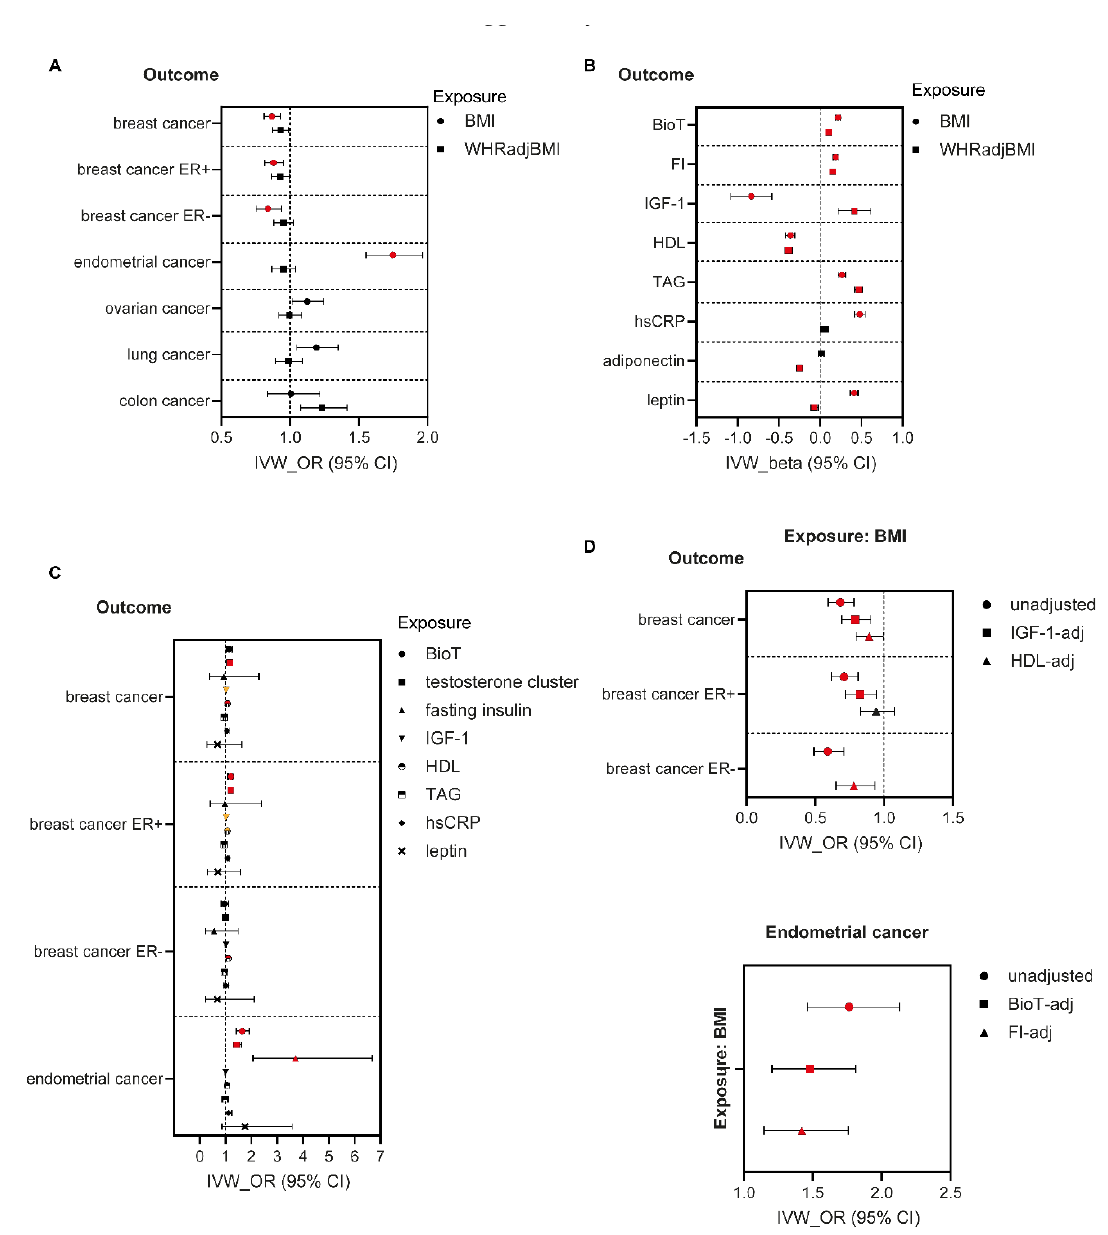
Figure 1. Two sample MR (IVW) estimates of effects of adiposity measures and traditional cancer drivers on cancer risk in women. ( A ) IVW estimates (OR, 95%CI) of effects of BMI and WHRadjBMI on cancer risk in women. ( B ) IVW estimates (beta, 95%CI) of effects of BMI and WHRadjBMI on potential cancer mediators in women. ( C ) IVW estimates (OR, 95%CI) of effects of mediators on cancer risk in women. ( D ) Mediation analyses: IVW estimates of effects of BMI on breast and endometrial cancers, adjusted for indicated mediator.,Red-filled symbols: Analyses yielding IVW results with p ≤ 0.005 ( A ), p ≤ 0.005 ( B ), and p ≤ 0.003 ( C ) (Bonferroni correction for multiple testing) and that are directionally consistent across all sensitivity analyses, and ( D ) p < 0.05 with adjustment for mediator. Orange-filled symbols in ( C ): IVW results with p ≤ 0.009 and that are directionally consistent across all sensitivity analyses. BioT, bioavailable testosterone; FI, fasting insulin; IGF-1, insulin-like growth factor-1; HDL, high-density lipoprotein cholesterol; TAG, triglycerides; hsCRP, high-sensitivity C-reactive protein; ER, oestrogen